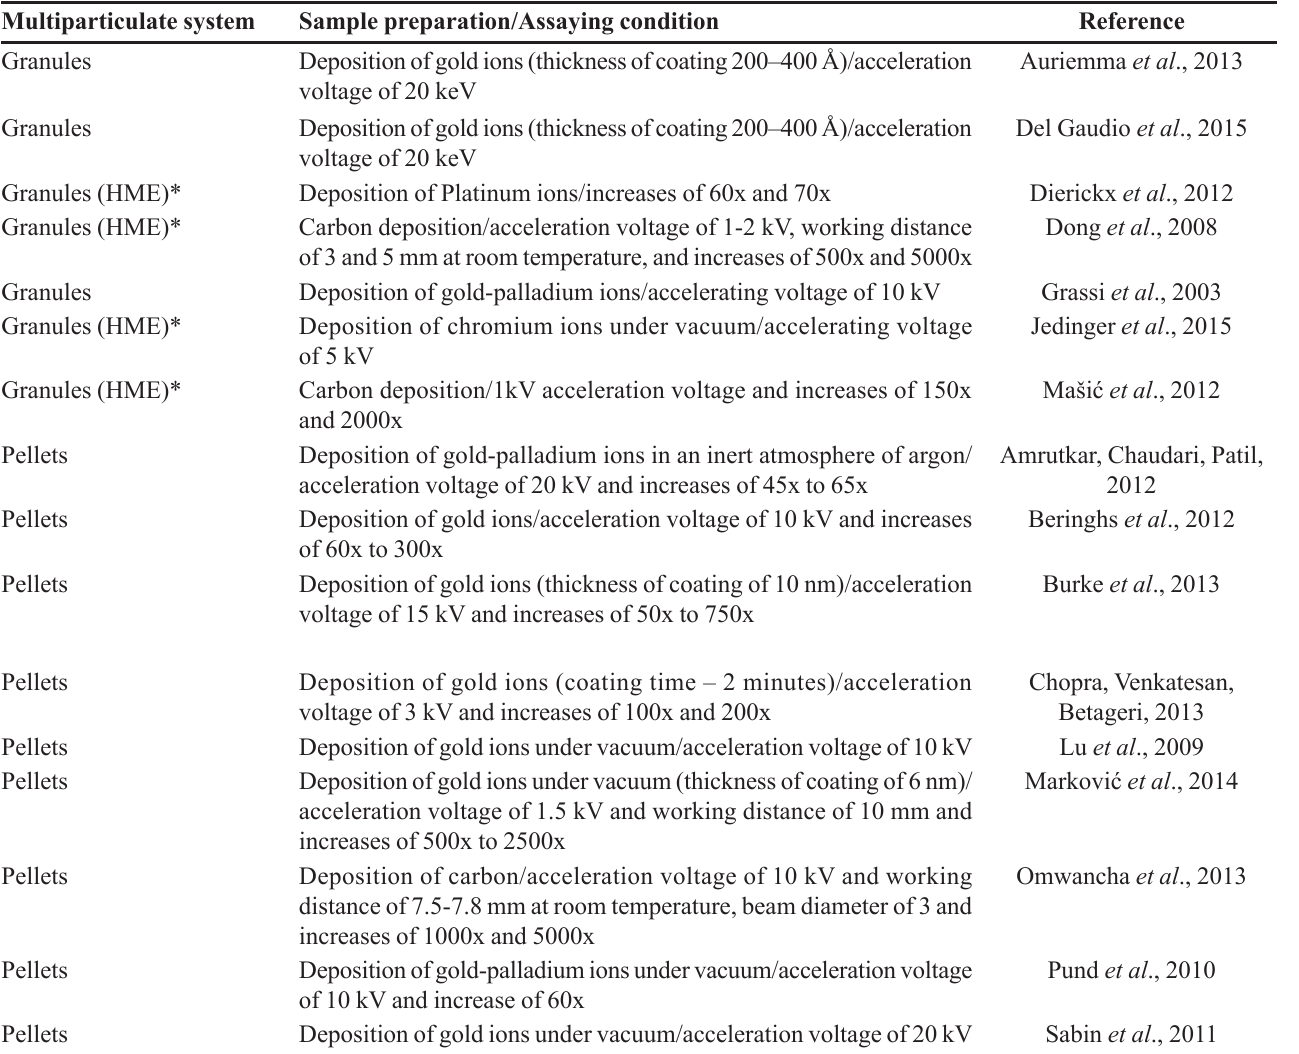
TABLE III - Example descriptions of parameters used in SEM Multiparticulate